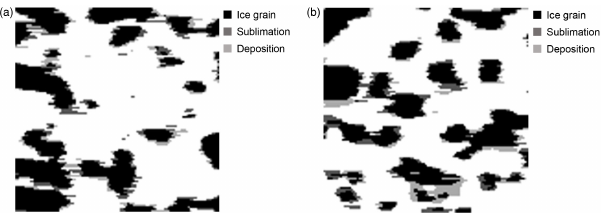
Figure 6. Superposition of vertical cross-section parallel to the flow direction at time 0 and 96h for (a) “sa3” and (b) “sa4”. Sublimation and deposition of water vapour on the ice grain were visible with an uncertainty of